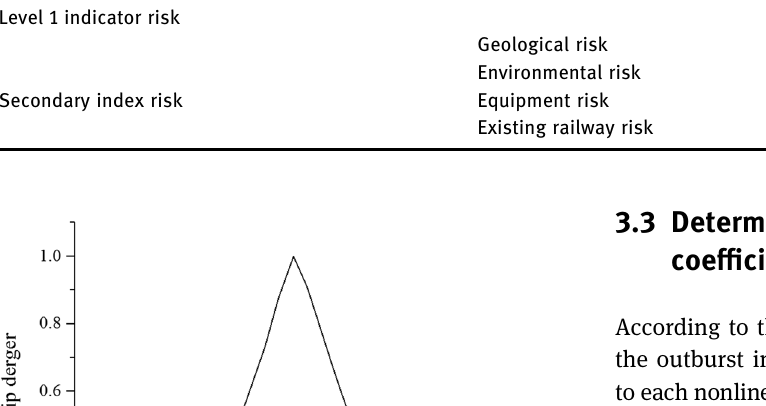
Table 3: Values of prominent in fl uence coe ffi cient vectors of risk factor sets at all levels Risk factor set